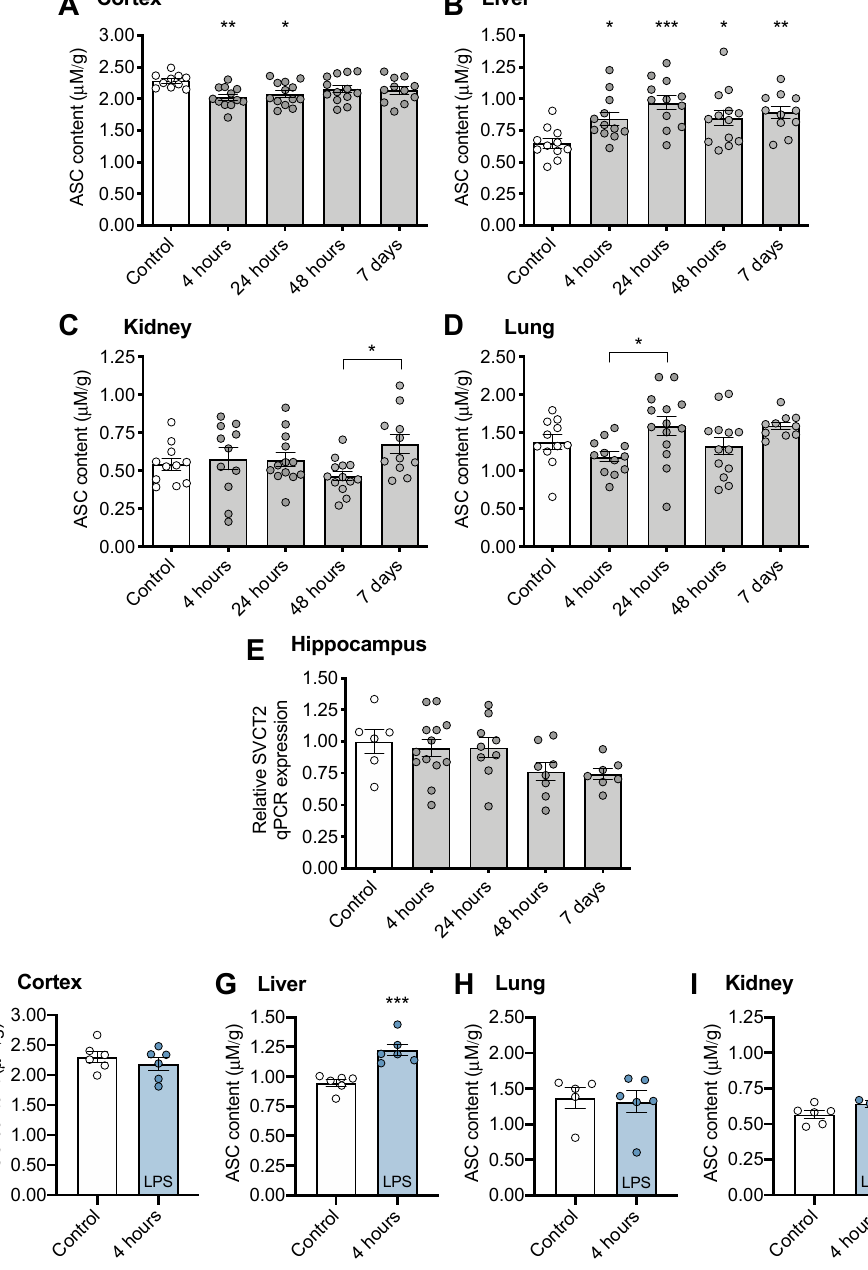
Figure 2. Tissue ASC (ascorbate) concentrations following CS treatment in ( A ) cortex, ( B ) liver, ( C ) kidney, ( D ) lung. ( E ) Sodium-dependent vitamin C transporter 2, SVCT2 gene expression in brain following CS treatment. Tissue ASC concentrations following LPS treatment ( F ) brain, ( G ) liver, ( H ) lung, and ( I ) kidney. * p < 0.05 ** p < 0.01 *** p < 0.001 from control following significant ANOVA results unless otherwise indicated. Error bars plotted as mean ± SEM.